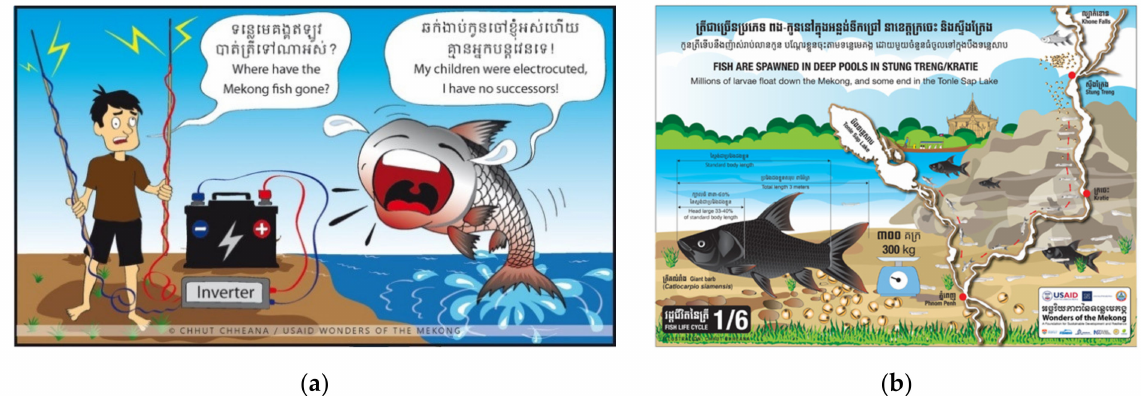
Figure 5. Examples of graphics from the Wonders of the Mekong project shared on social media, including ( a ) an awareness- raising cartoon about the harms of illegal electrofishing; ( b ) the first in a series of infographics about the life cycle of the giant